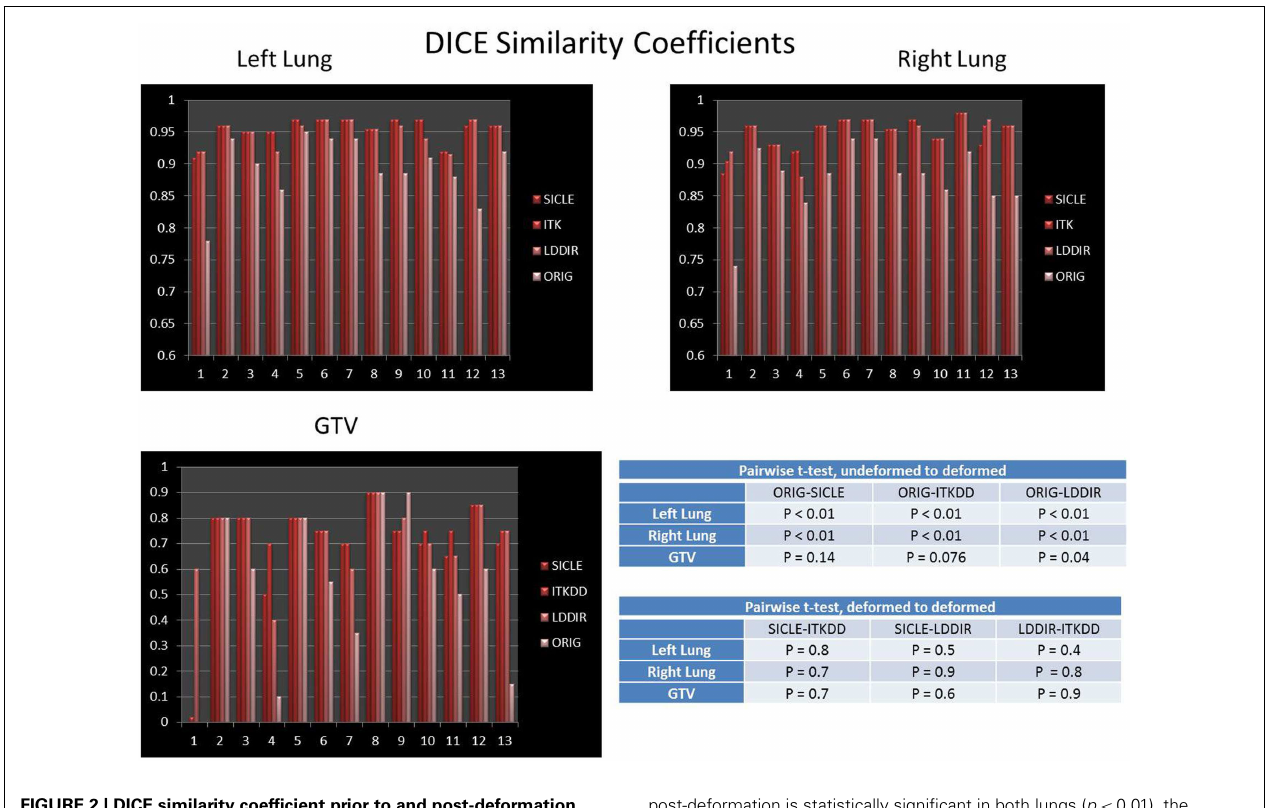
FIGURE 2 | DICE similarity coefficient prior to and post-deformation for both lungs and GTV .Tables show p -values for pairwise t -test of differences between undeformed DICE and deformed DICE, and pairwise t -test for agreement between deformed DICE generated by three algorithms.The difference between DICE prior to deformation and DICE